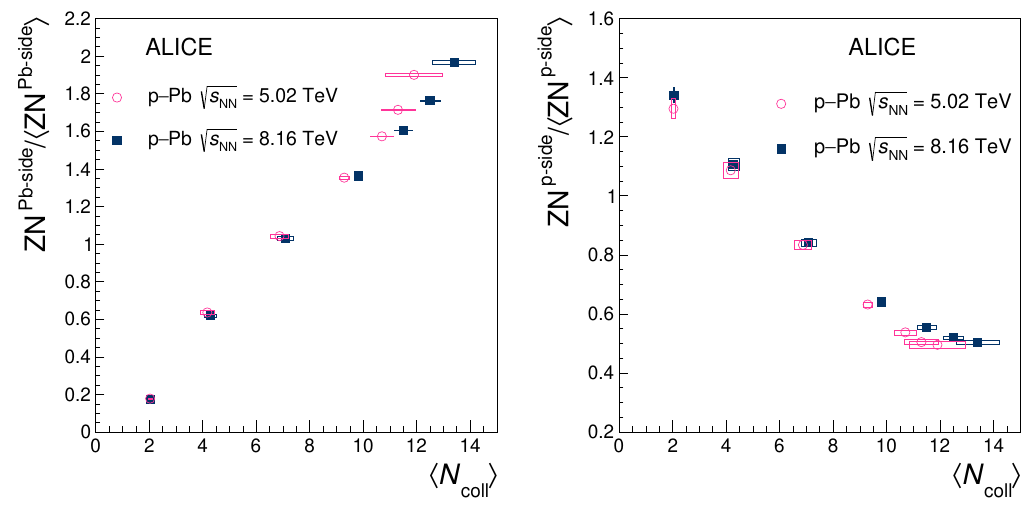
Figure 4 . ZN energy normalised to the average MB value in the Pb-fragmentation (left) and in the p- fragmentation (right) regions as a function of the average N (pink circles) and 8 . 16 TeV (blue squares). The boxes represent the systematic uncertainty.